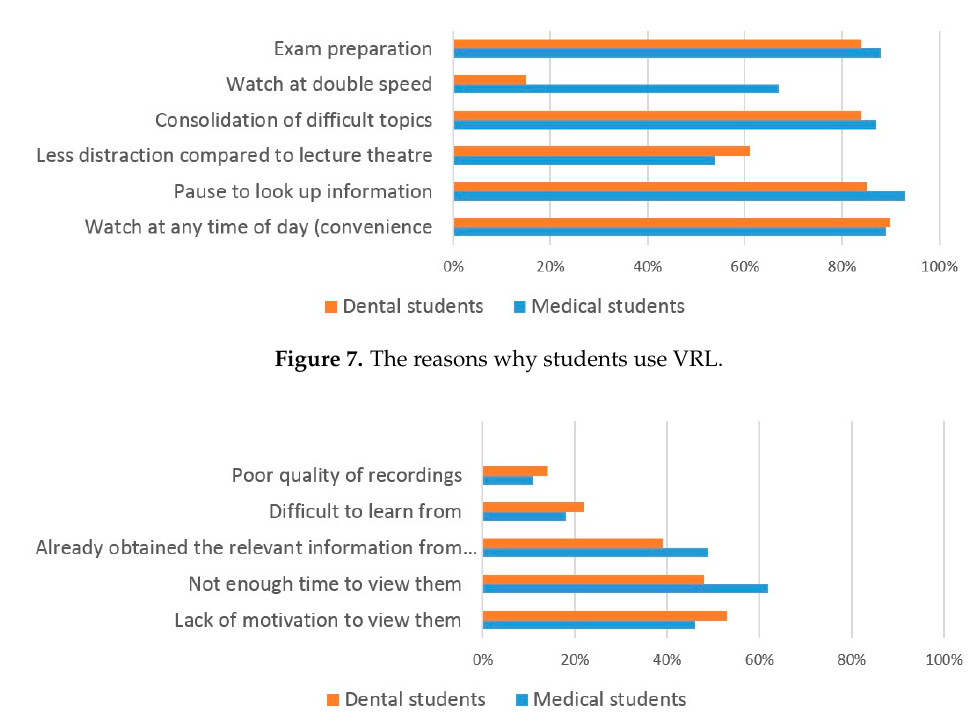
Figure 8. The reasons why students do not use VRL.